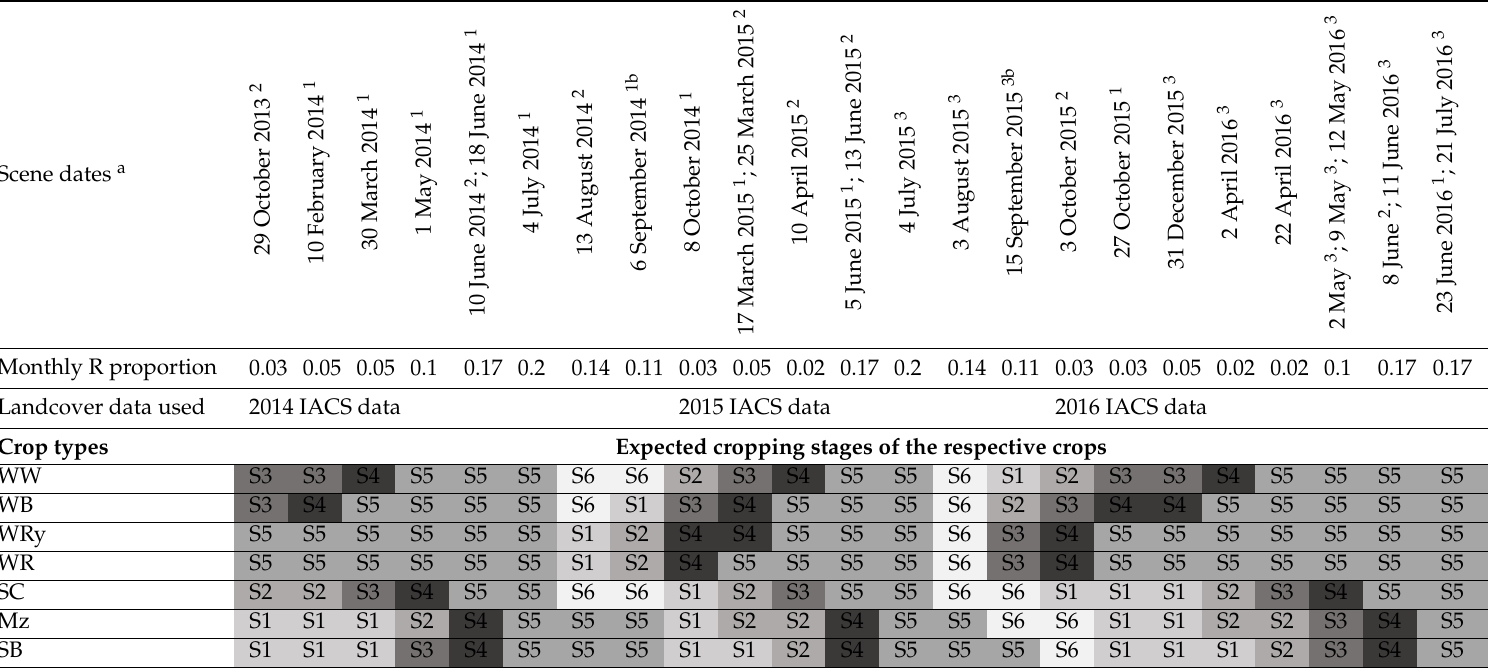
Table 2. Satellite images allocation in relation to the expected phenological stages of the various crop types considered in the analysis. The percentage of the ground cover by respective crops’ canopy was determined as per Table